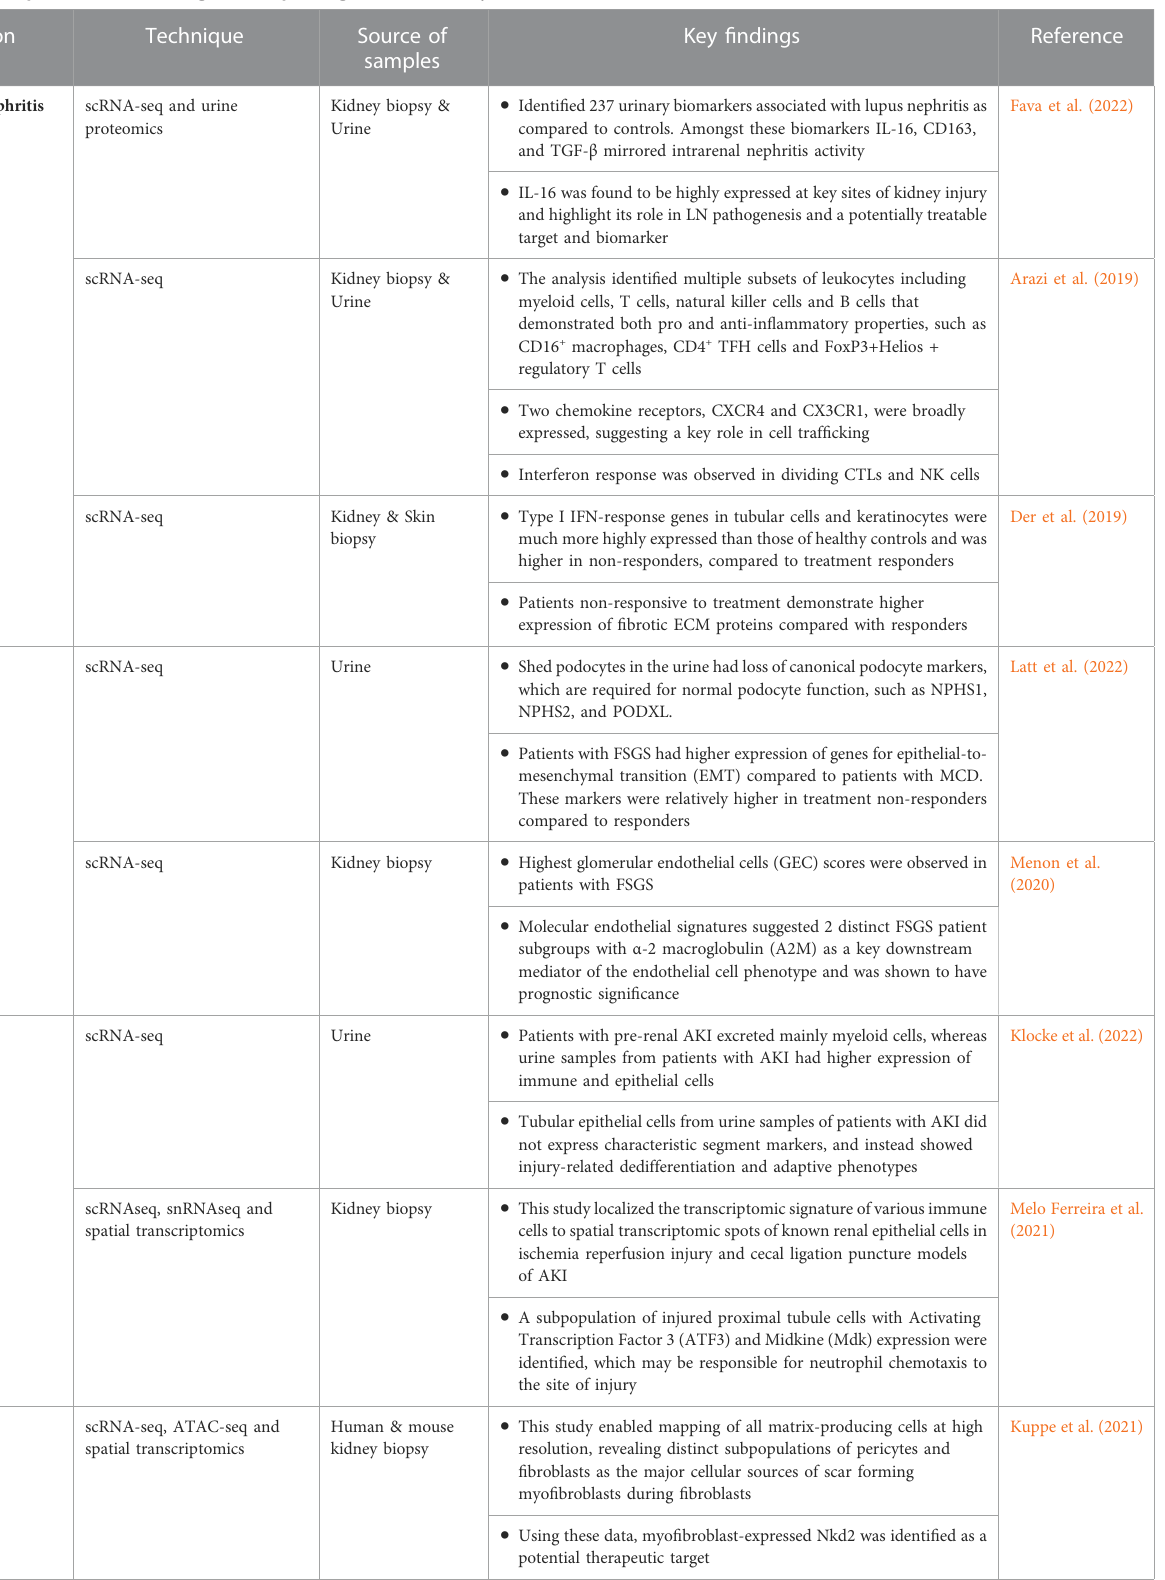
TABLE 1 Examples of multi-omic single cell sequencing studies in kidney